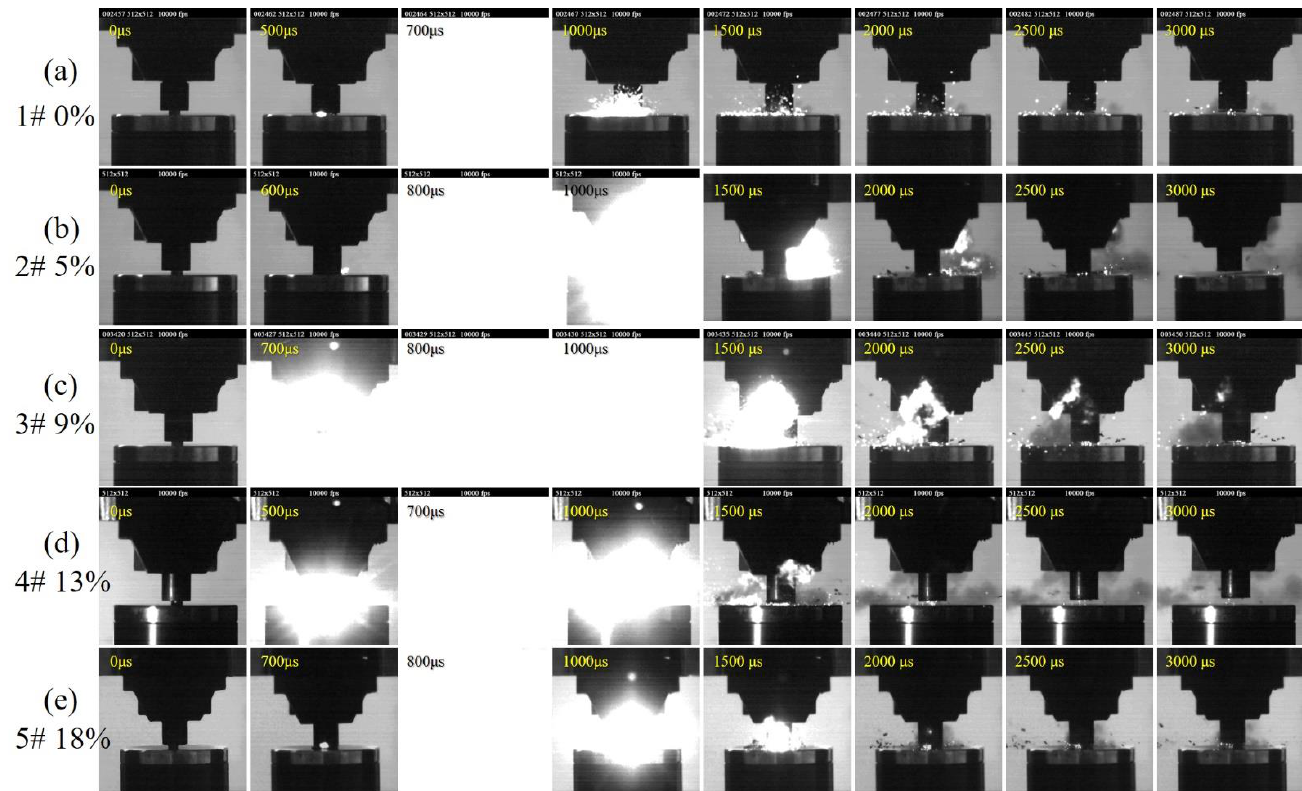
Figure 3. Shock-induced chemical reaction process images (height = 150 cm): ( a ) PA 1#; ( b ) 2#PAB-5%; ( c ) 3#PAB-9%; ( d ) 4# PAB-13%; ( e ) 5#PAB-18%.